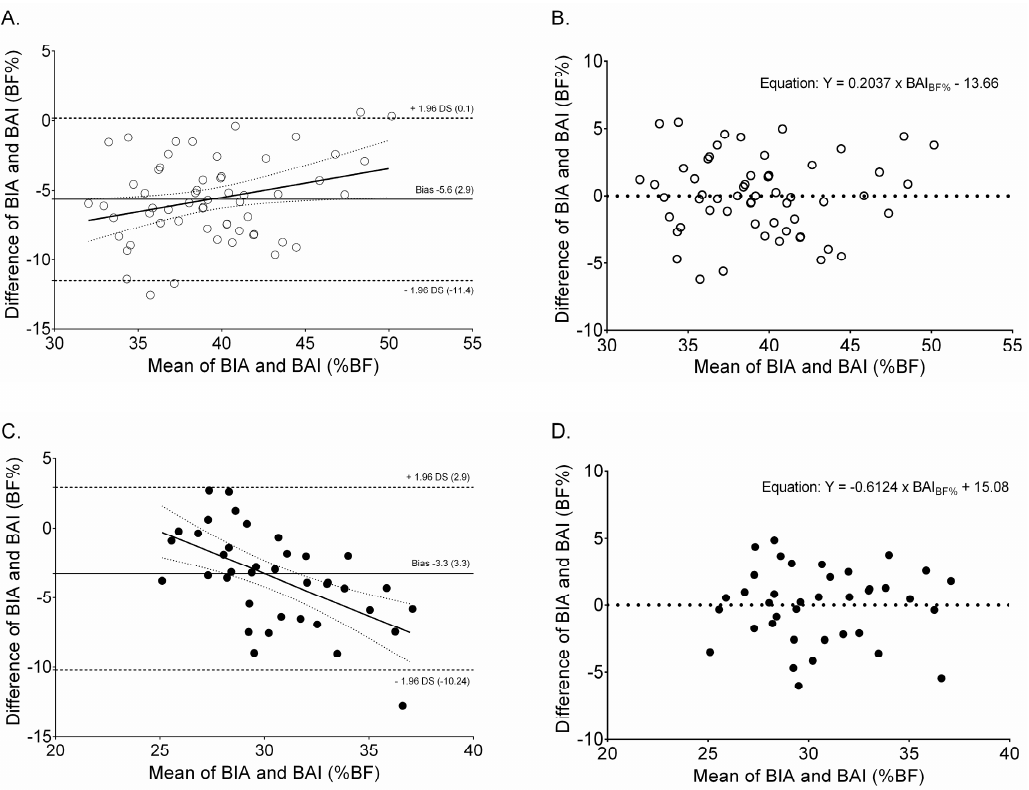
Figure 1. Bland-Altman plots with mean bias (central line) and 95% limits of agreement for comparing BAI-BF% and BIA-BF% among women ( A ), and men ( C ). Panels ( B , D ) represent residual values for Bland-Altman linear regression. The central line represents the systematic bias between BAI-BF% and BIA-BF%; the outer lines represent 95% limits. Solid lines represent the regression line and dashed lines indicate ± 1.96 SD. SD: standard deviation.